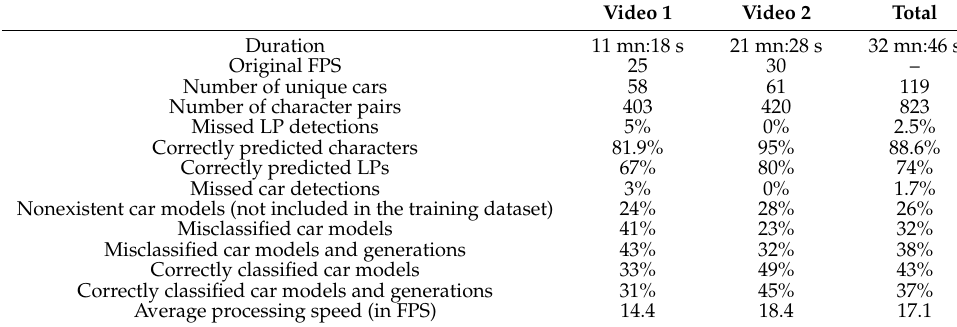
Figure 14. Sample frame from the processing of video 2. This online visualization is only used for checking and debugging purposes. Otherwise, it is disabled, because it significantly slows down the program, as the instantaneous FPS value on the top right reveals. Table 10. Evaluation of the car and license plate recognition system (using Model 2b for character recognition) on two videos recorded under realistic conditions on the PSU